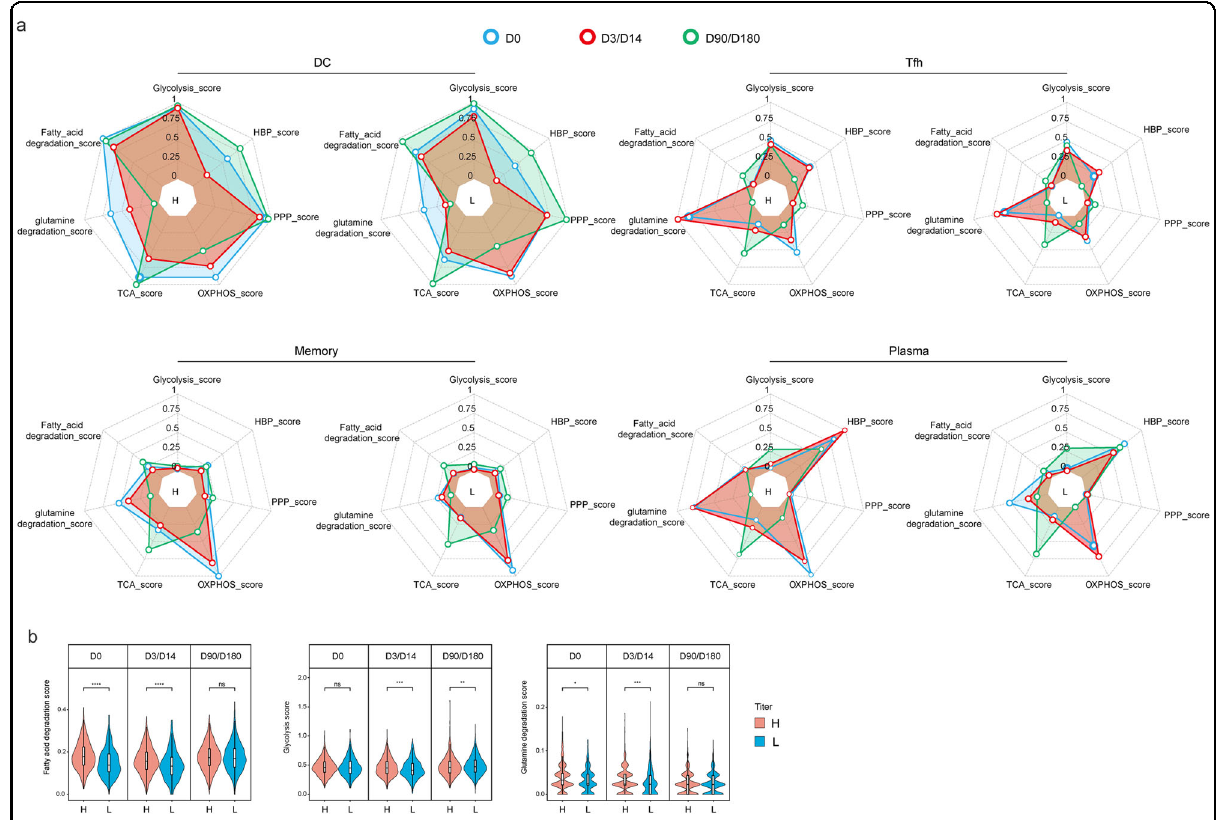
Fig. 7 Energy metabolism of the key immune cells involved in humoral immunity. a Radar Plots shows energy metabolism pathway scores and relative carbon metabolism pathway scores normalized according to all scored cells, ranging from 0 to 1. b Violin plots show the Fatty acid degradation score, Glycolysis score and Glutamine degradation score of cDCs between high- and low-antibody-titer groups at D0, D3/D14 and D90/ D180. Values are means ± SD. * P < 0.05, ** P < 0.01, *** P <